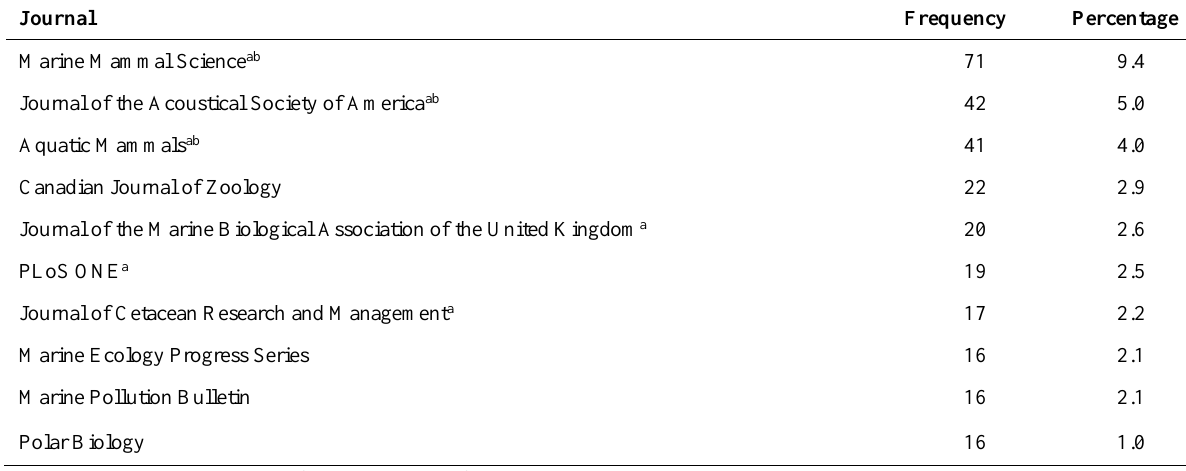
Top Ten Journals Publishing Killer Whale Articles Most Frequently from the Study Sample